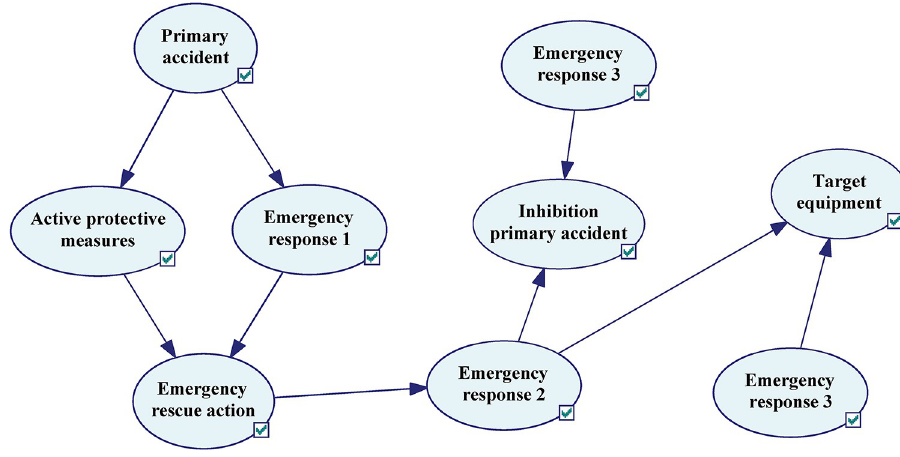
Fig 6. The emergency rescue process fitted by the Bayesian network